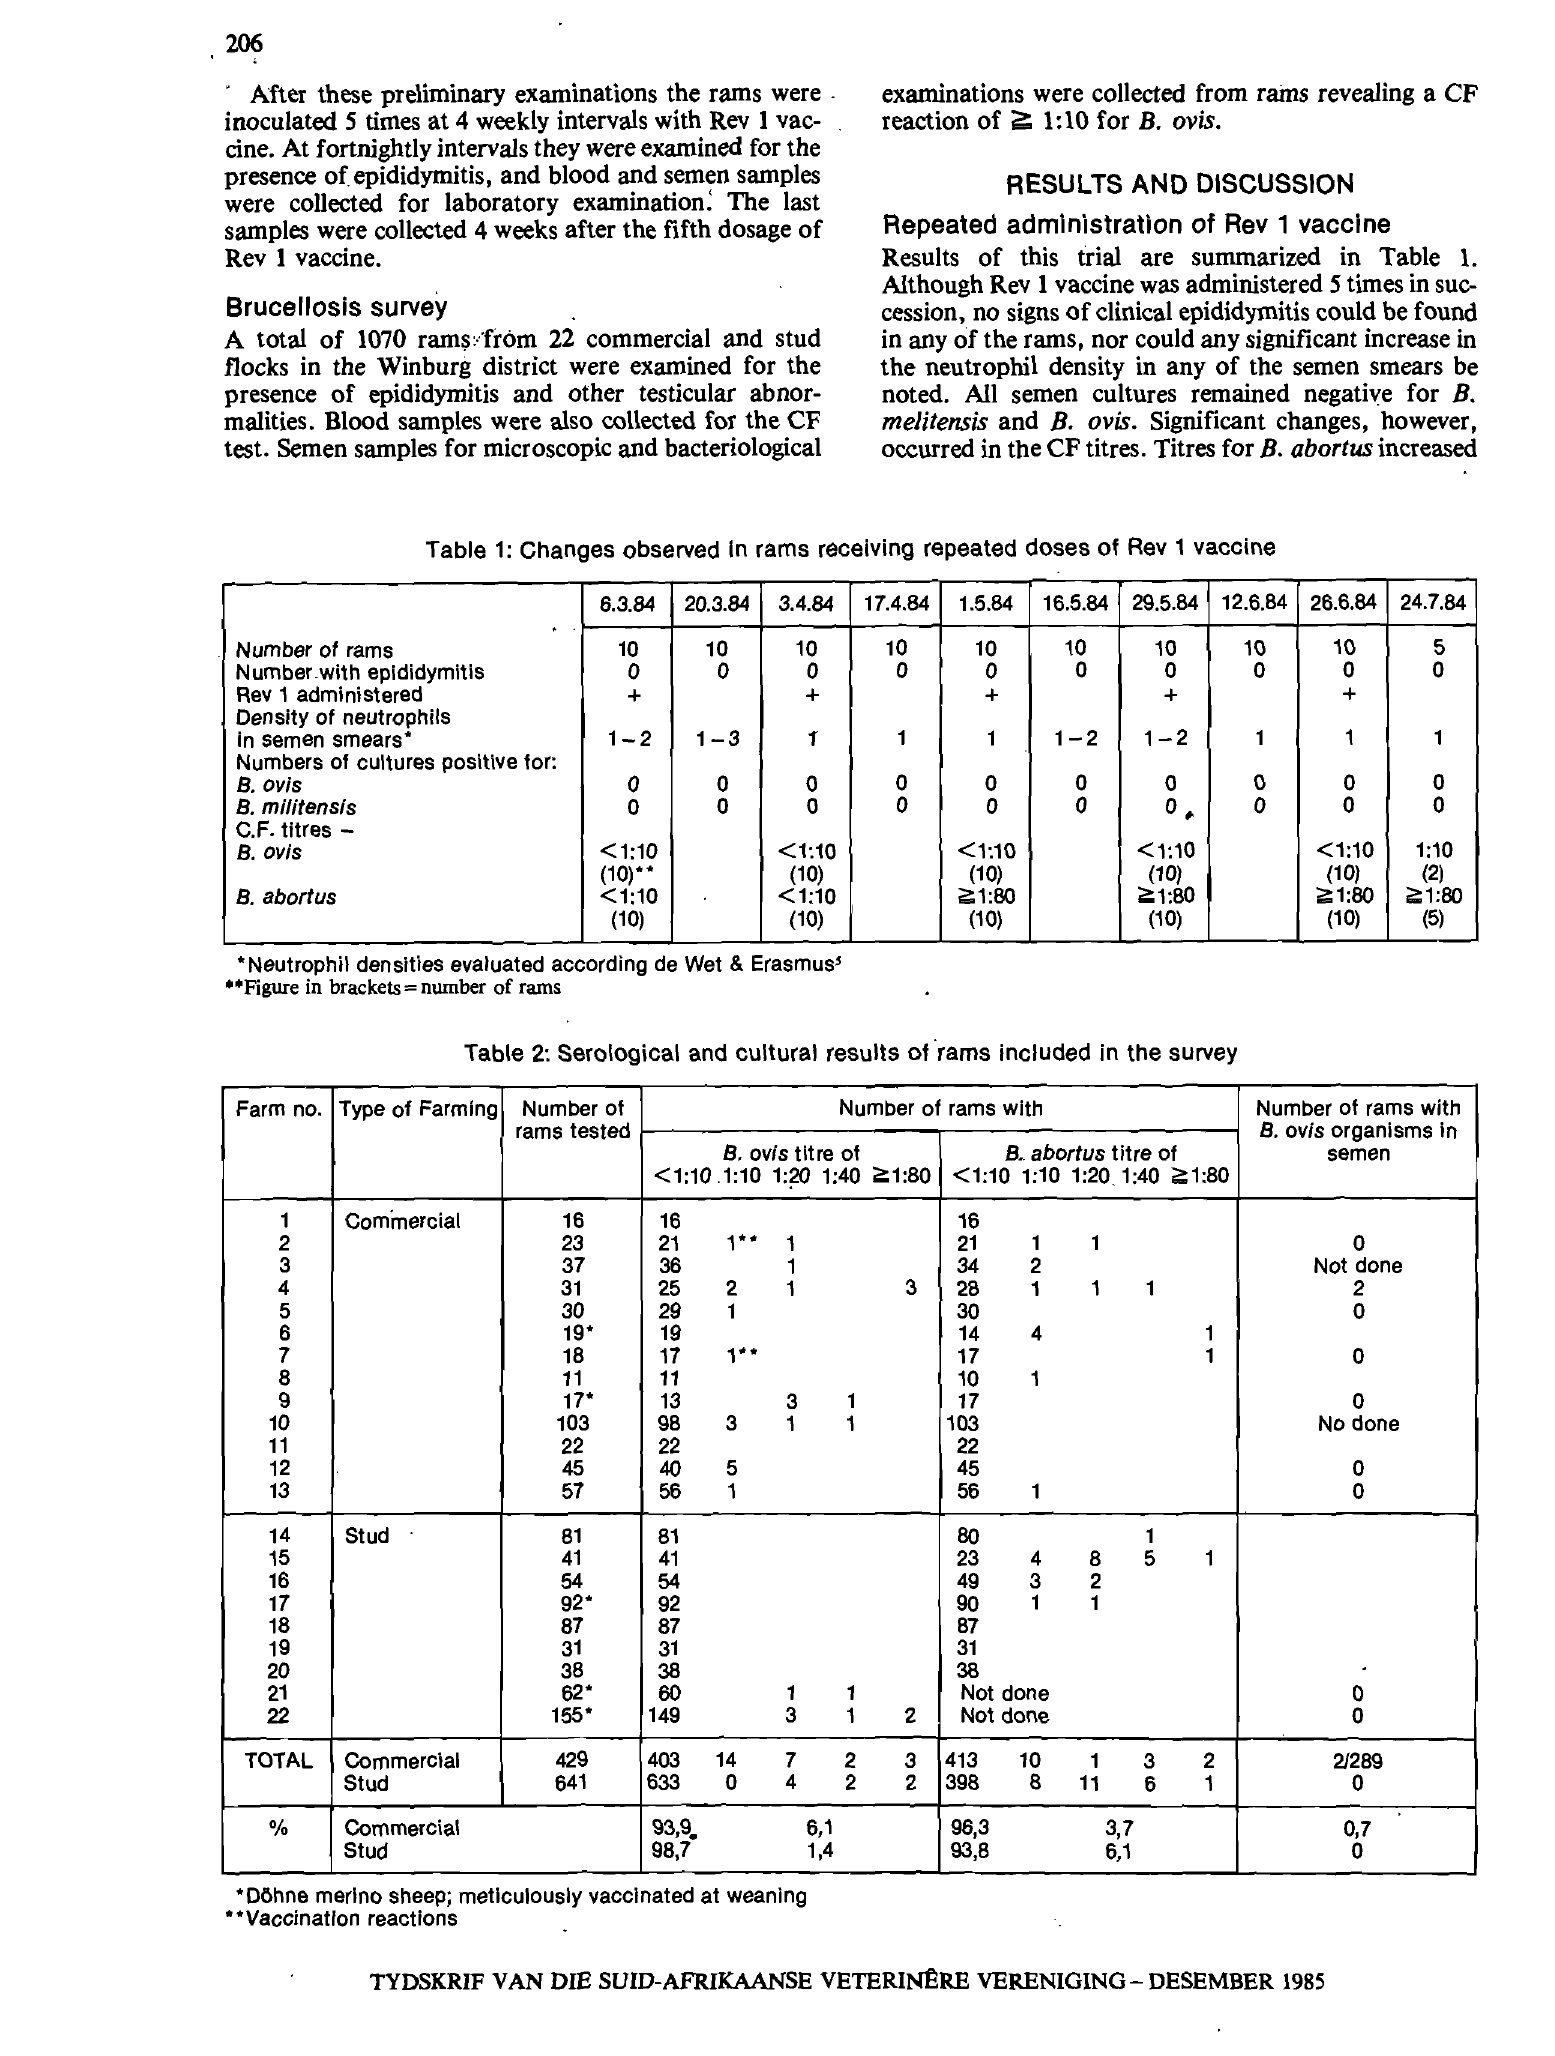
Table 1: Changes observed in rams receiving repeated doses of Rev 1 vaccine